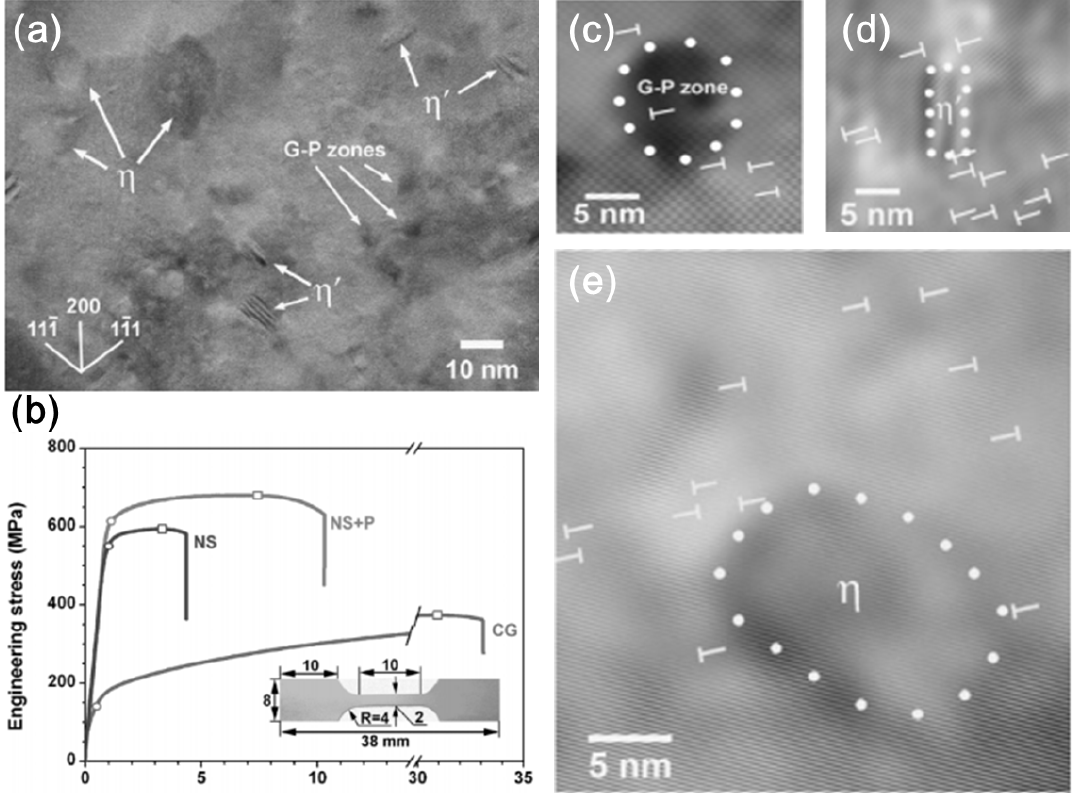
Figure 1: (a) prosperous precipitations in NS+P 7075 sample (b) Engineering stress-strain curves of the samples (c-e) 111 matrix planes obtained by inverse Fourier transformations of HRTEM images of an NS+P sample. White dots mark particle/matrix interface [39].